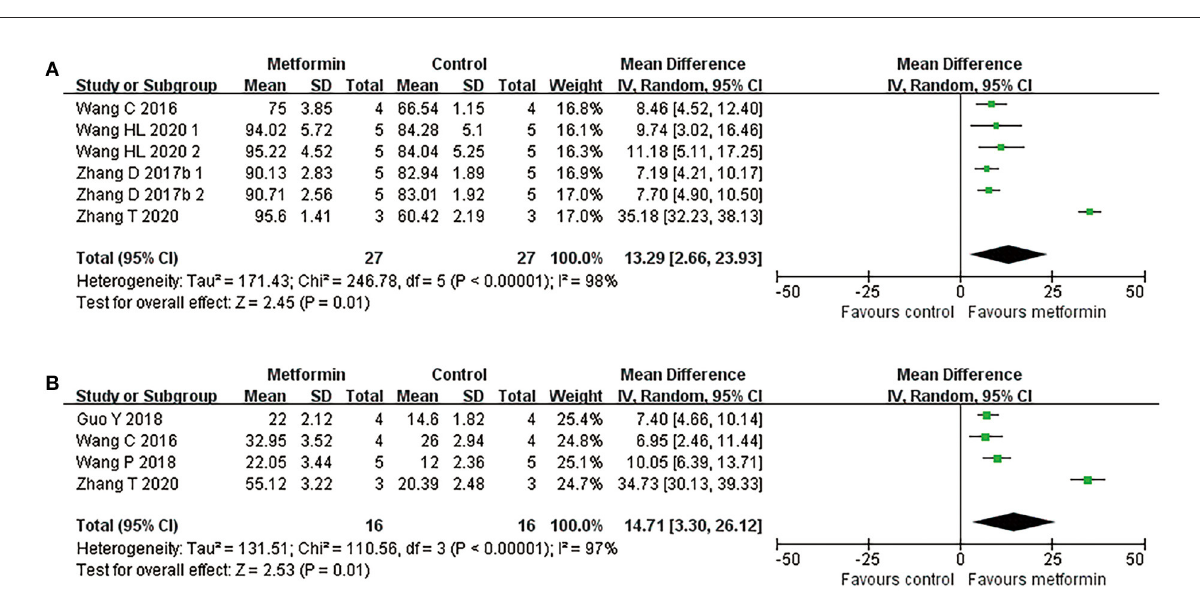
FIGURE3 Overall analyses of the effects of metformin on tissue damage in lesion area. (A,B) Tissue preservation area ratio, number of survival motor neuron meta-analysis in lesion area and the effect sizes line chart.